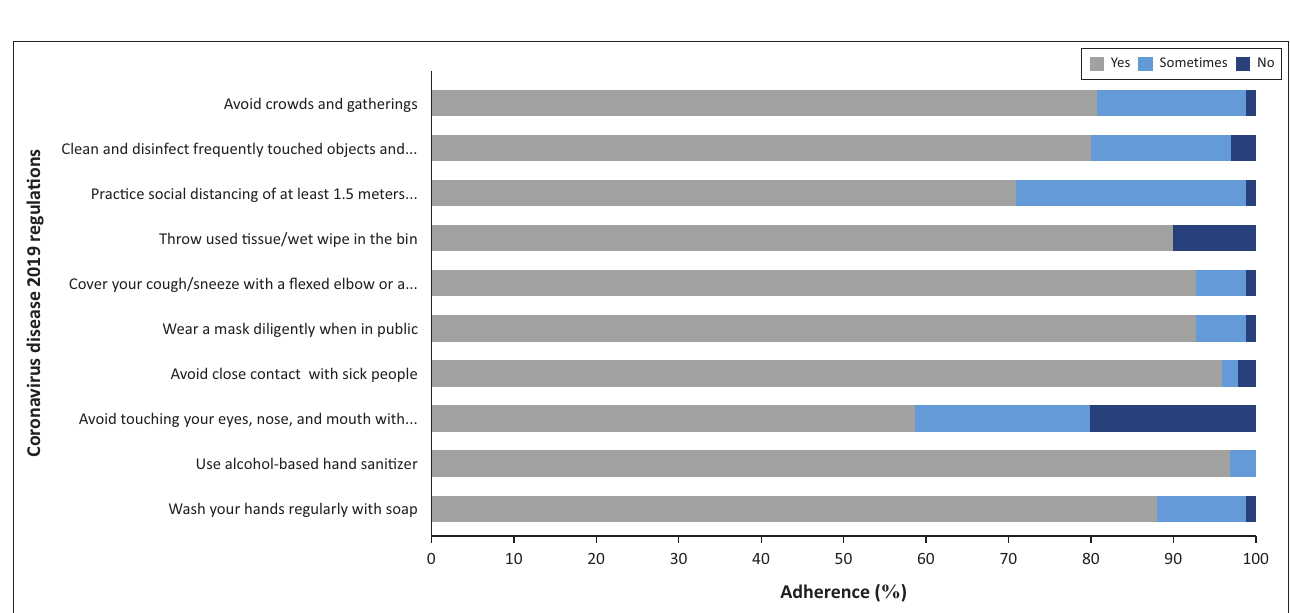
FIGURE 1: Respondents per suburb in Bloemfontein.